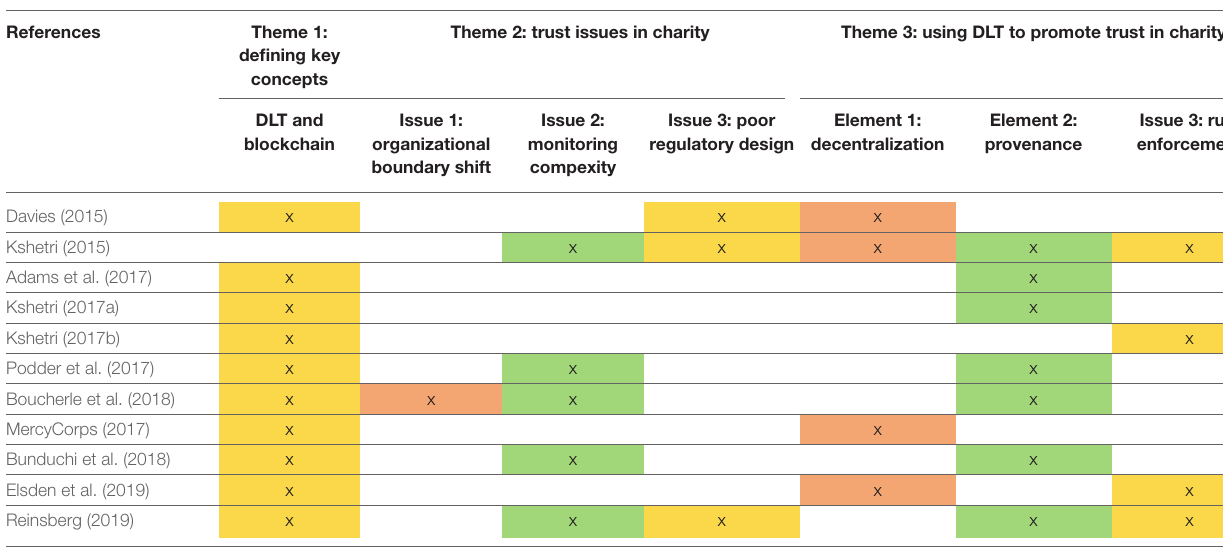
TABLE 5 | Thematic analysis of Group B